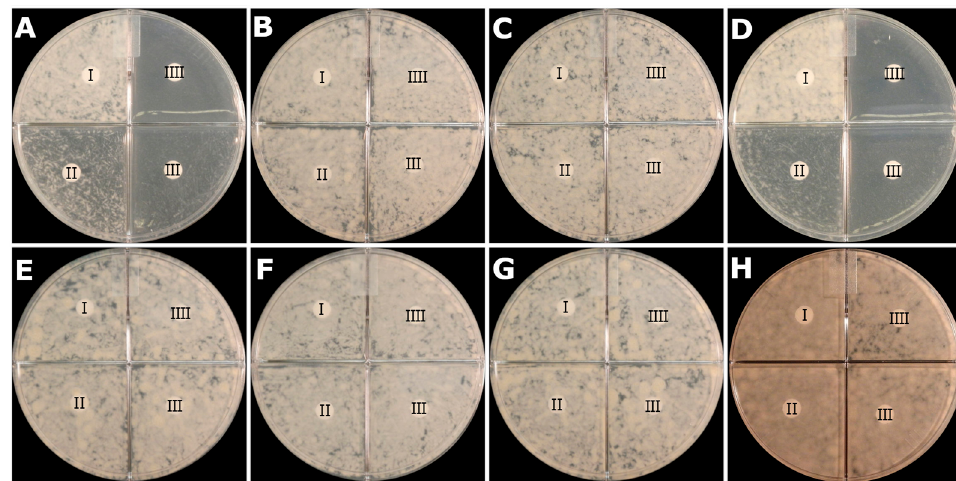
Figure 4. Growth inhibition of M. tuberculosis by PZA at pH 6.8 on PZA-S1 minimal medium agar plate. ( A ), M. tuberculosis H37Ra, PZA-susceptible strain; ( B ), M. tuberculosis H37Ra PZA R #6